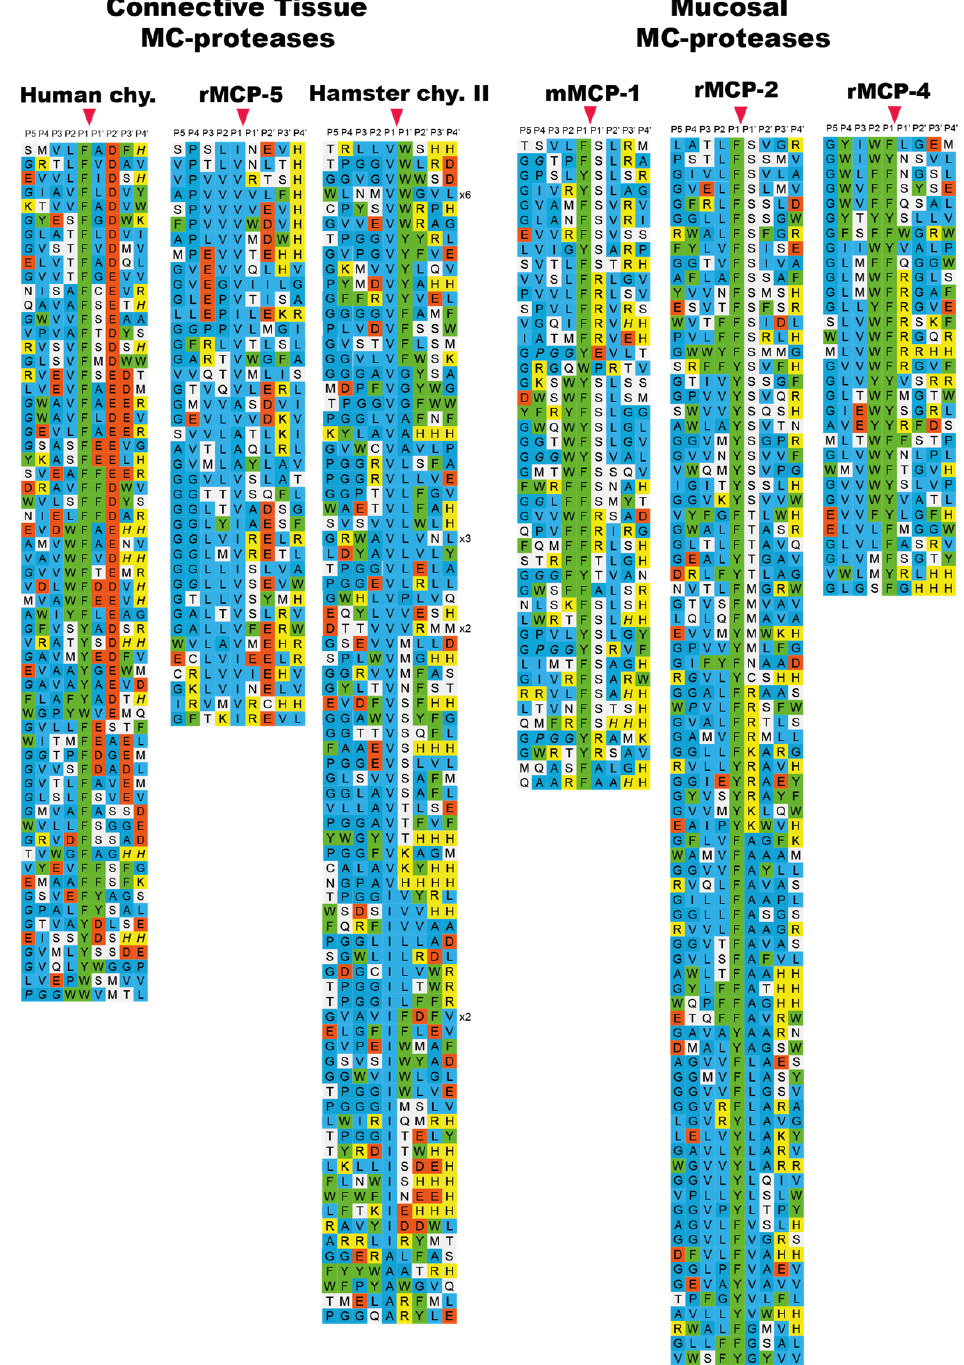
Figure 6. Phage display results for a panel of rodent α -chymases that has become elastases and of a panel of mucosal mast cell specific β -chymases. The amino acids in the phage display results are color coded as shown in Figure 4. The cleavage by the enzyme occur after the P1 residue as marked by red arrow heads. The figure contains data from six earlier publications